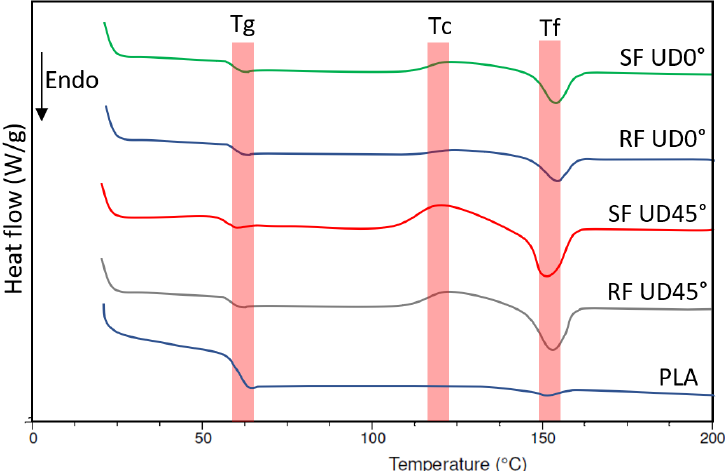
Figure 8. DSC analysis on the different fiber organizations in the composite (Tg: glass transition temperature, Tc: crystallinity temperature, Tf: fusion temperature).